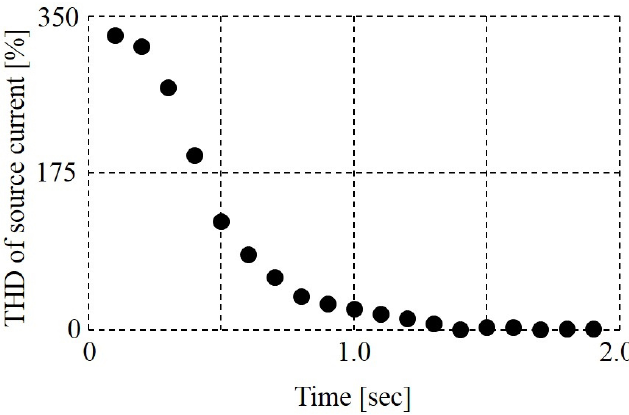
Figure 8. Source current total harmonic distortion (THD) of the soft-starter for the 100-kW SCIM in Figure